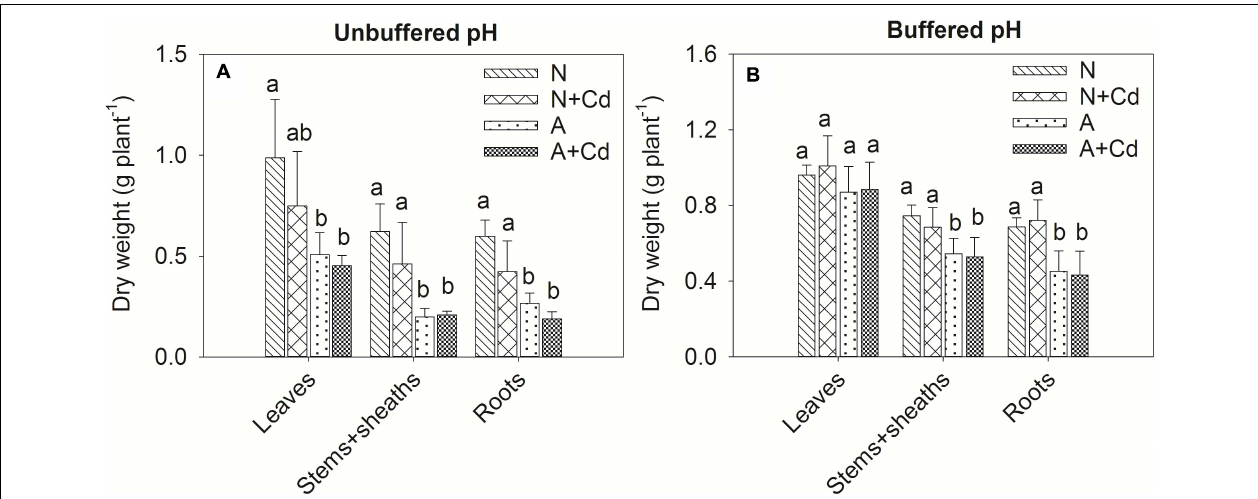
FIGURE 2 | Dry weight of leaves, stems + sheaths and roots in sweet sorghum as affected by nitrate and ammonium in the presence or absence of Cd under unbuffered (A) or buffered (B) pH condition. N, nitrate; N + Cd, nitrate with Cd; A, ammonium; A + Cd, ammonium with Cd. Different letters above the bars of one organ represented significant differences at the level of 0.05 based on One-Way ANOVA and Duncan’s multiply